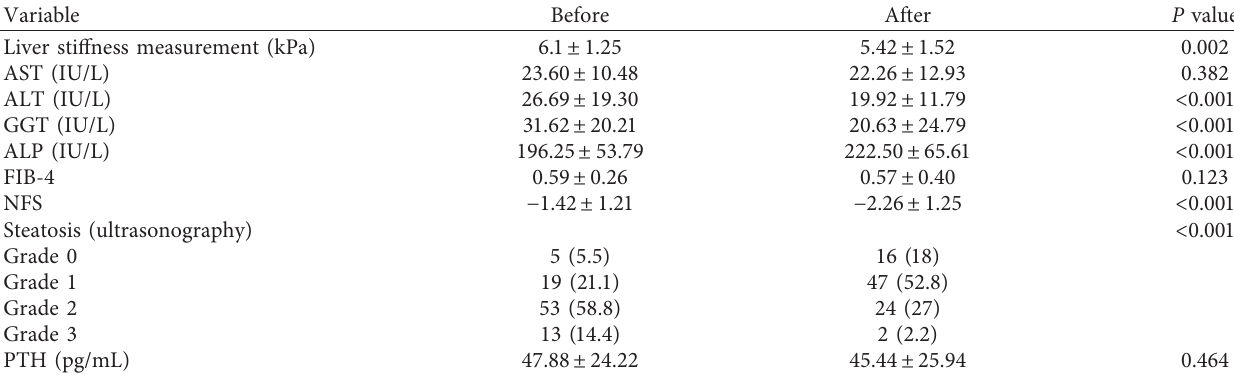
Table 3: Liver status and PTH level in clinically severe obese patients before and after bariatric surgery. Variable Before